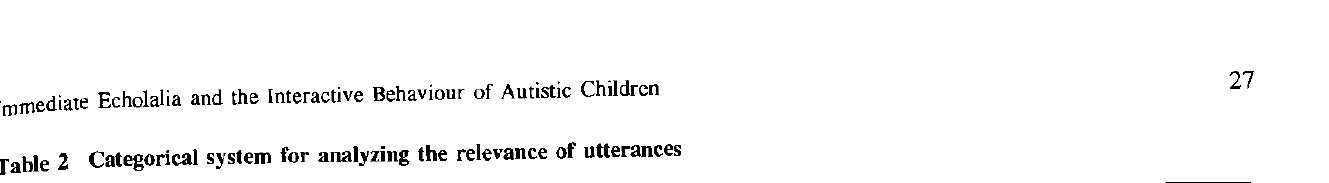
Table 2 Categorical system for analyzing the relevance of